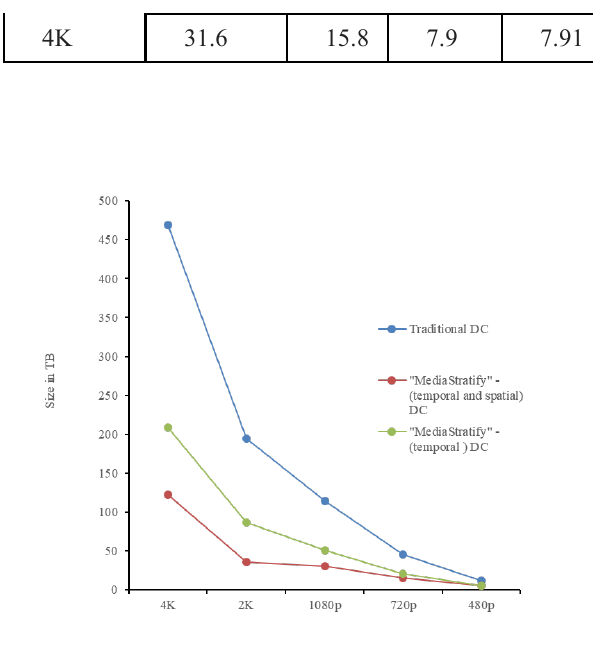
Figure 7. Storage savings due to "MediaStratify" for